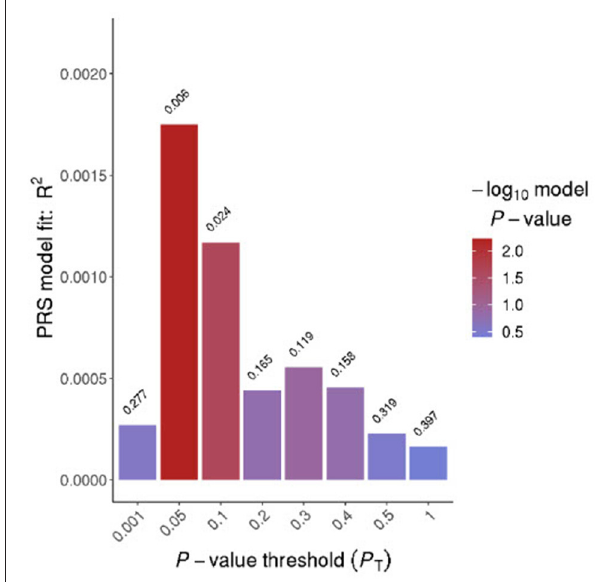
FIGURE 1 | Bar plot for Insomnia. The x-axis displays eight different p -value thresholds derived from the fast-score option in PRSice. R 2 represents Nagelkerke’s R -squared and the values on the top of the bars represent the p -values for that threshold.